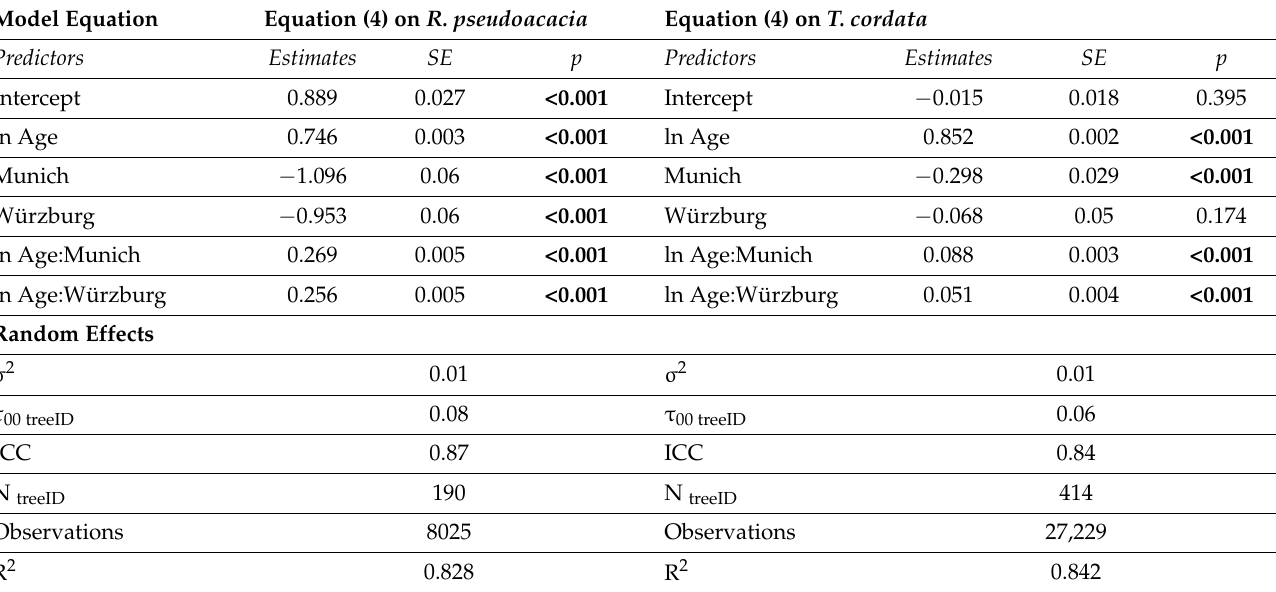
Table A2. Statistical results of the linear mixed effect model described by Equation (4) on the diameter growth for R. pseudoacacia in Santiago de Chile, Munich, and Würzburg and T. cordata in Berlin, Munich, and Würzburg. Significant p values ( p < 0.05) are shown in bold.